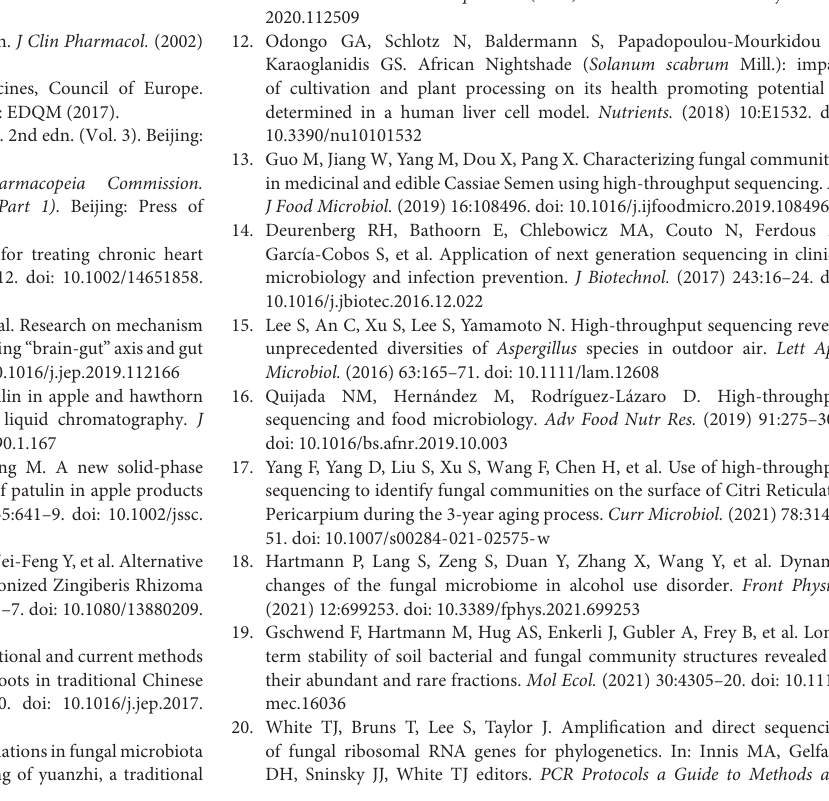
Supplementary Table 1 | Distribution of operational taxonomic units (OTUs) for 21 Crataegi Fructus (CF) samples. Supplementary Table 2 | Alpha diversity indices in each CF